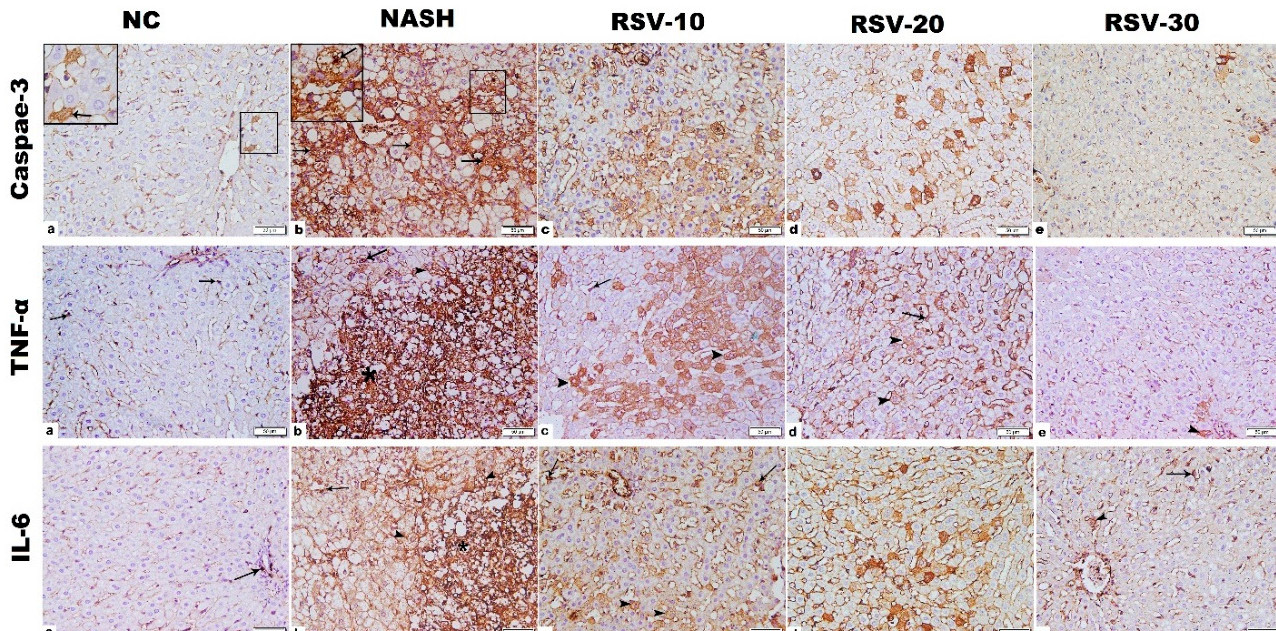
Figure 5. Photomicrographs of Caspase-3, TNF- α and IL-6 immunohistochemistry-stained liver sections. (1) Caspase-3; ( a ) NC group: few cells with cytoplasmic positive immunostaining (IS) were detected (inset), NASH group ( b ): widespread strong cytoplasmic, mainly, and nuclear (inset) positive IS. RSV-10 ( c ): many cells with cytoplasmic, mainly, and nuclear positive IS. RSV-20 ( d ): scattered cells with cytoplasmic positive IS. RSV-30 ( e ) showed few cells with weak cytoplasmic positive IS. (2) TNF- α ; NC group ( a ): cytoplasmic positive immunostaining (IS) in macrophage lining sinusoid (arrow). NASH group ( b ): widespread strong cytoplasmic positive IS, mainly in the inflammatory cell infiltration (star), in addition to cells lining sinusoids (arrow) and hepatocytes (arrowhead). RSV-10 ( c ): cytoplasmic positive IS in numerous hepatocytes (arrowhead) in addition to cells lining sinusoids (arrow). RSV-20 ( d ): cytoplasmic positive IS in scattered hepatocytes (arrowhead) and cells lining sinusoids (arrow). RSV-30 ( e ): few hepatocytes with weak cytoplasmic positive IS (arrowhead). (3) IL-6; NC group ( a ): cytoplasmic positive immunostaining (IS) in few cells (arrow). NASH group ( b ): massive strong cytoplasmic positive IS, mainly in the inflammatory cell infiltration (star), in addition to cells lining sinusoids (arrow) and hepatocytes (arrowhead). RSV-10 ( c ): cytoplasmic positive IS in numerous hepatocytes (arrowhead) in addition to cells lining sinusoids (arrow). RSV-20 ( d ): cytoplasmic positive IS in scattered hepatocytes (arrowhead) and cells lining sinusoids (arrow). RSV-30 ( e ): few hepatocytes (arrowhead) and cells lining sinusoids (arrow) with cytoplasmic positive IS. [Magnification: 200×; inset: 400]. Table 2. The effect of rosavin on the mean area % of Caspase ‐ 3, TNF ‐α and IL ‐ 6 immunostaining.